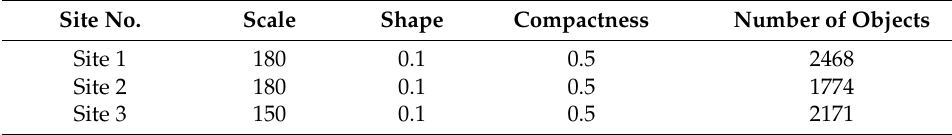
( c ) Figure 7. Morphological building index images: ( a ) Site 1; ( b ) Site 2; and ( c ) Site 3 imagery. In this study, a confusion matrix was used to calculate the accuracy of building de- tection. The reference data used for accuracy evaluation identified only HRB objects on the digital map and expressed them as binary images. To evaluate the performance of the proposed method, a comparison with a previous research method used for building de- tection, which uses shadows, was also conducted [42]. In previous studies, shadow objects were extracted by calculating the shadow intensity [43] using the blue band ( B ) and green band ( G ), as shown in Equation (17), after detecting object-based building candidate groups. After that, the final building object was detected by calculating the direction be- tween the building object and the shadow. In this chapter, only the rough status of the